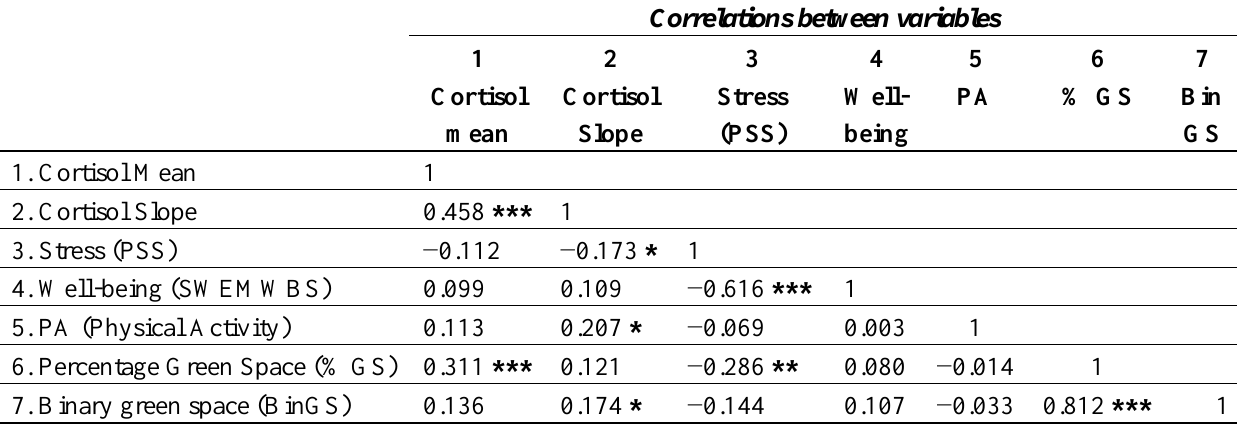
Table 2. Relationships between cortisol patterns, health measures and percentage green space.